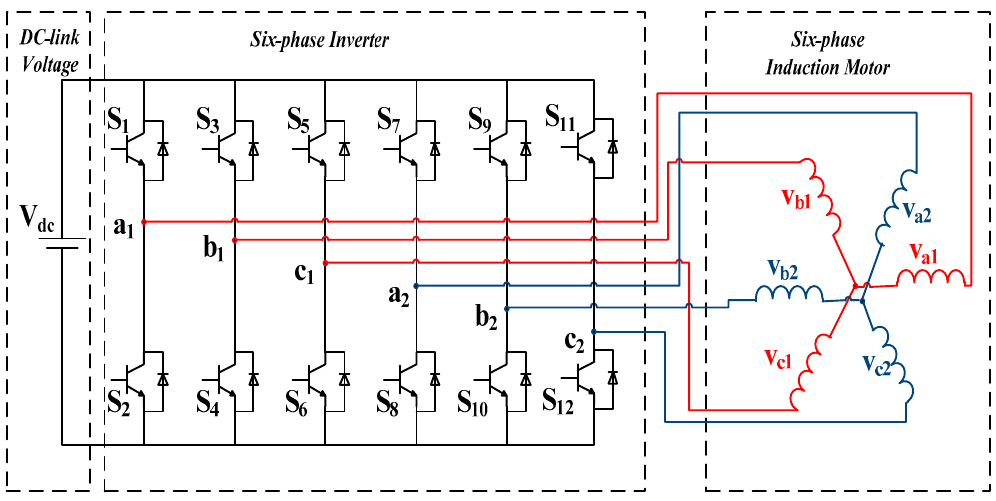
Figure 1. Six-phase induction motor drive.